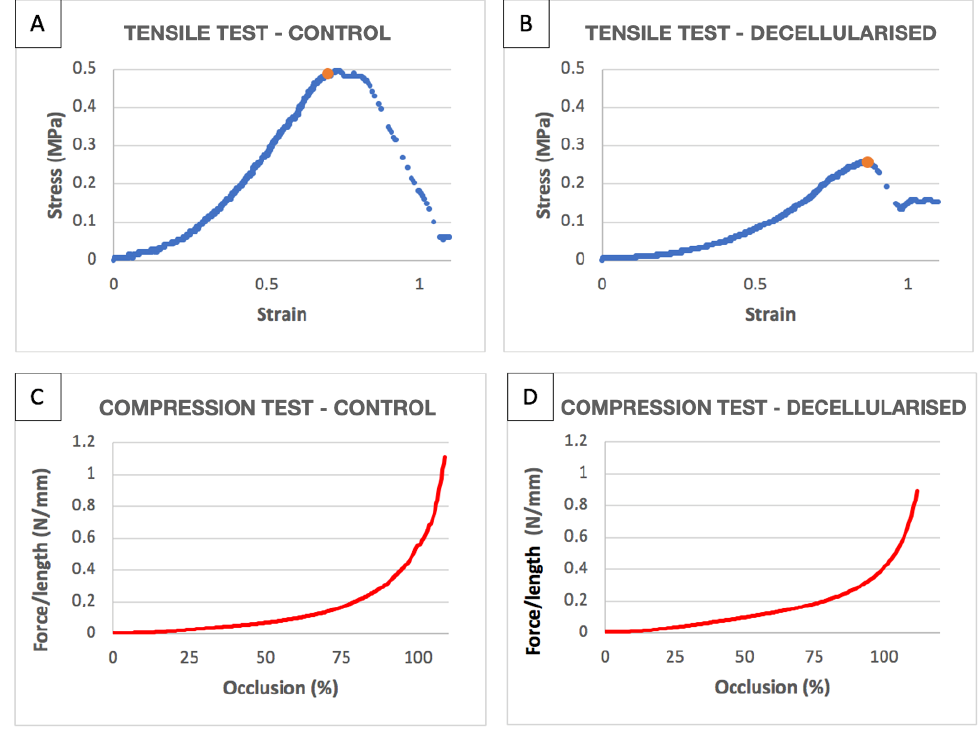
Figure 7. ( A ) Stress–strain graphs of tensile tests on a control trachea. ( B ) Stress–strain graphs of tensile tests on decellularised trachea. The orange dot marks the maximum or break point. ( C ) f curve by percentage occlusion of compression tests on a control trachea. ( D ) f curve by percentage occlusion of compression tests on a decellularised